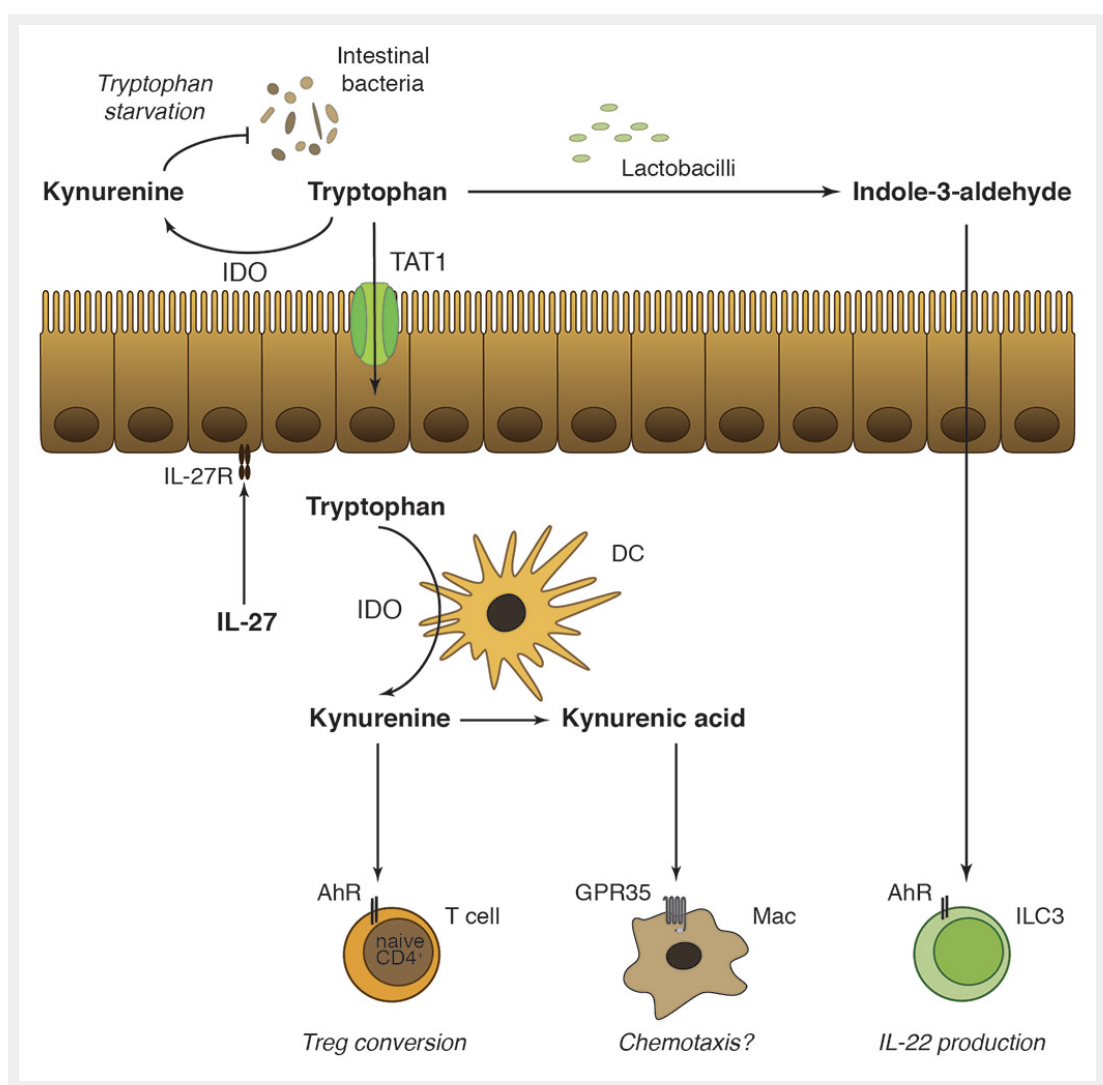
Figure 3 Constituents of the gut microflora and immune system of the host metabolise the essential amino acid tryptophan. The essential amino acid tryptophan is shuttled via the T-type amino acid transporter 1 (TAT1) across the intestinal barrier, metabolized by indoleamine-2,3-dioxygenase (IDO) expressed in dendritic cells (DC) to kynurenine and kynurenic acid. Kynurenine supports the conversion of T cells to regulatory T cells (Treg); kynurenic acid binds to the G-protein coupled receptor (GPR) 35 expressed by macrophages (Mac). Tryptophan is also metabolized by constituents of the microflora to indole-3-aldehyde, which binds to the aryl hydrocarbon receptor (AhR) facilitating IL-22 production by innate lymphoid cells